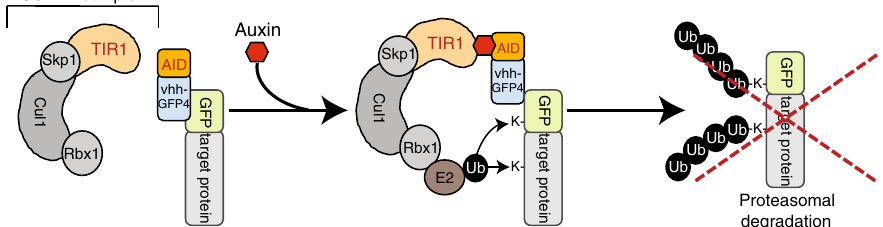
Fig. 1 Auxin-dependent degradation of GFP-tagged proteins by an anti-GFP nanobody. Schematic illustration of AID-nanobody degradation. GFP-tagged proteins are recognized by an AID-nanobody fusion. Addition of auxin triggers recruitment of the SCF TIR1 ubiquitin E3 ligase. Ubiquitylation of the GFP fusion protein occurs at lysine residues present in GFP and/or the target protein leading to proteasomal degradation. AID, auxin-inducible degron; Cul1, Cullin-1; Rbx1, RING-box protein 1; Skp1, S-phase kinase-associated protein 1; TIR1, transport inhibitor response 1; vhh-GFP4, anti-GFP